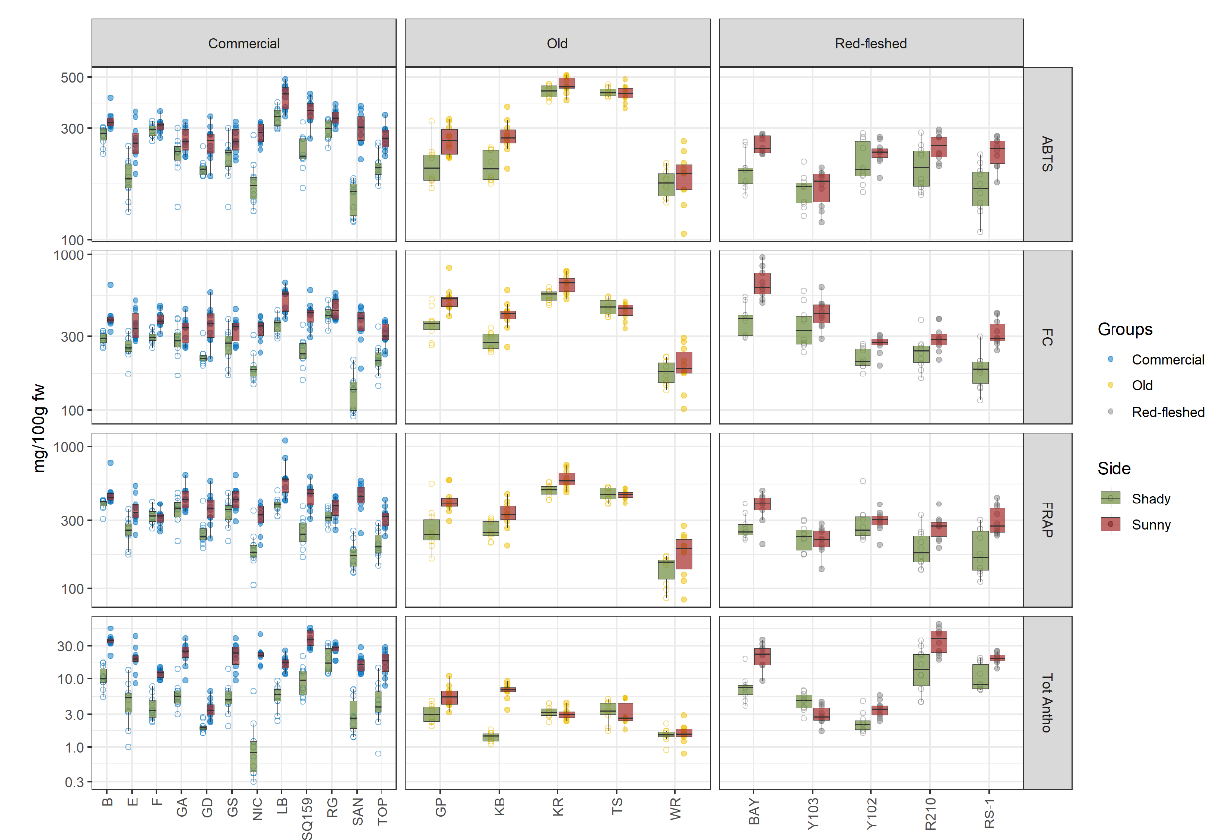
Figure 3. Results of FRAP, ABTS, FC, and Tot Antho in 22 apple varieties organized in three groups (old, commercial, and red-fleshed); 10 apples (biological replicates) per variety were sampled and the sunny and shadow exposed site of the apples were analyzed. The concentrations of these parameters were transformed in log-10 scale. FW = fresh weight. For apple variety names see Table 1.